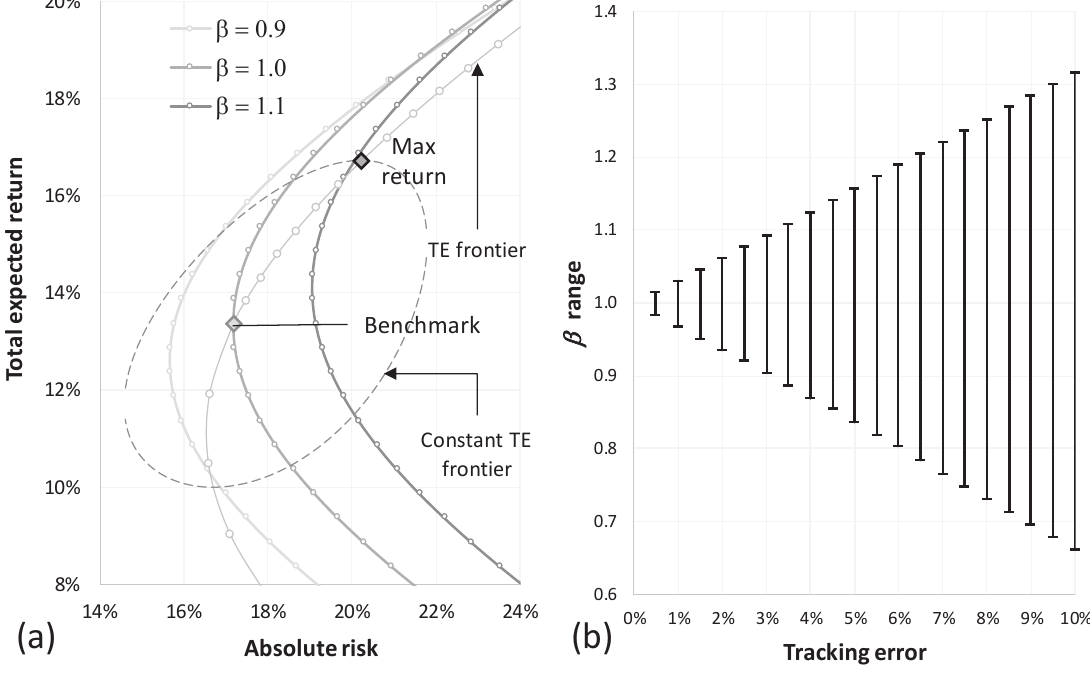
Figure 3. (a) Position of β frontier for 0 9, 1 0 . . β = and 1 1 . and (b) maximum and minimum β values for changing tracking